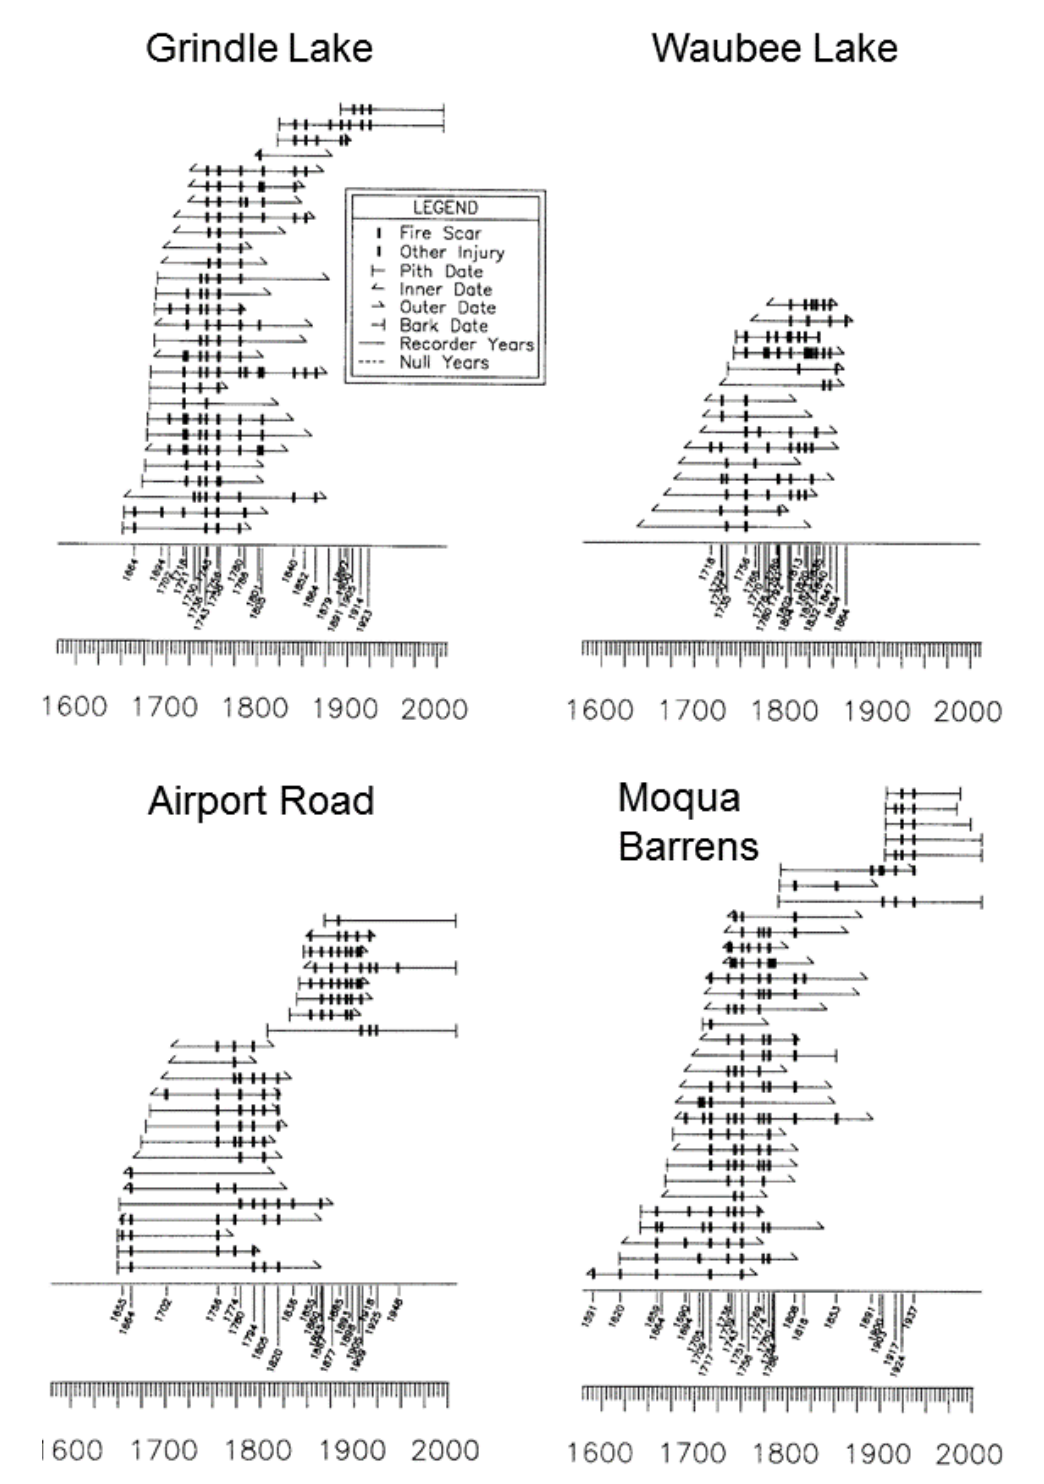
Figure 3. Fire history diagrams showing fire scar dates (vertical short lines) and composite fire scar records (bottom line with dates) at the four study sites. Each horizontal line represents the tree-ring record of a red pine remnant or living tree.